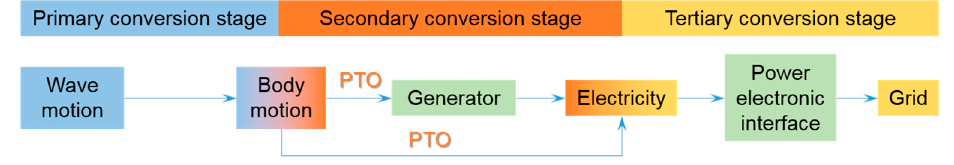
Figure 4. Main stages of wave energy conversion.